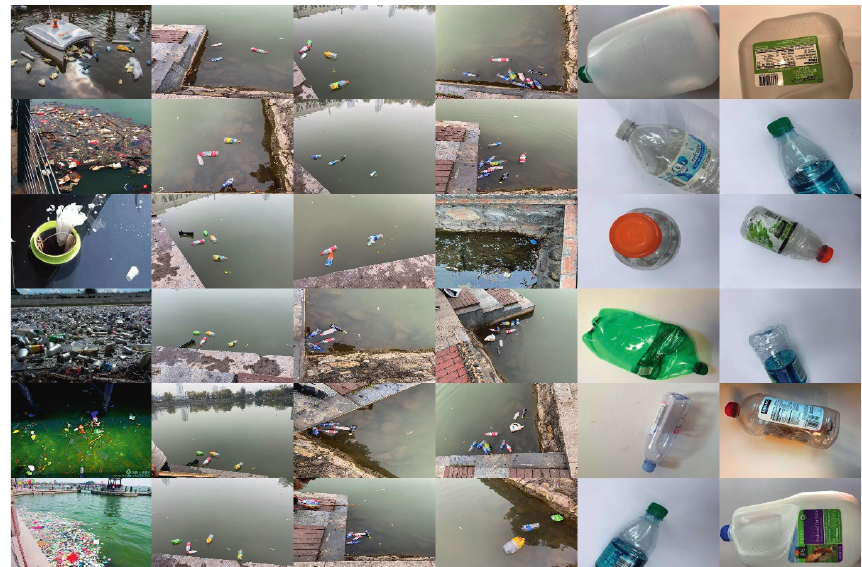
Figure 3: The water-surface garbage dataset, which contains 2000 color images in different scales, is developed for deep learning-based automatic detection of water-surface garbage. This current dataset is mainly composed of glass and plastic materials. More types of water- surface garbage will be incorporated into our dataset in the future work.